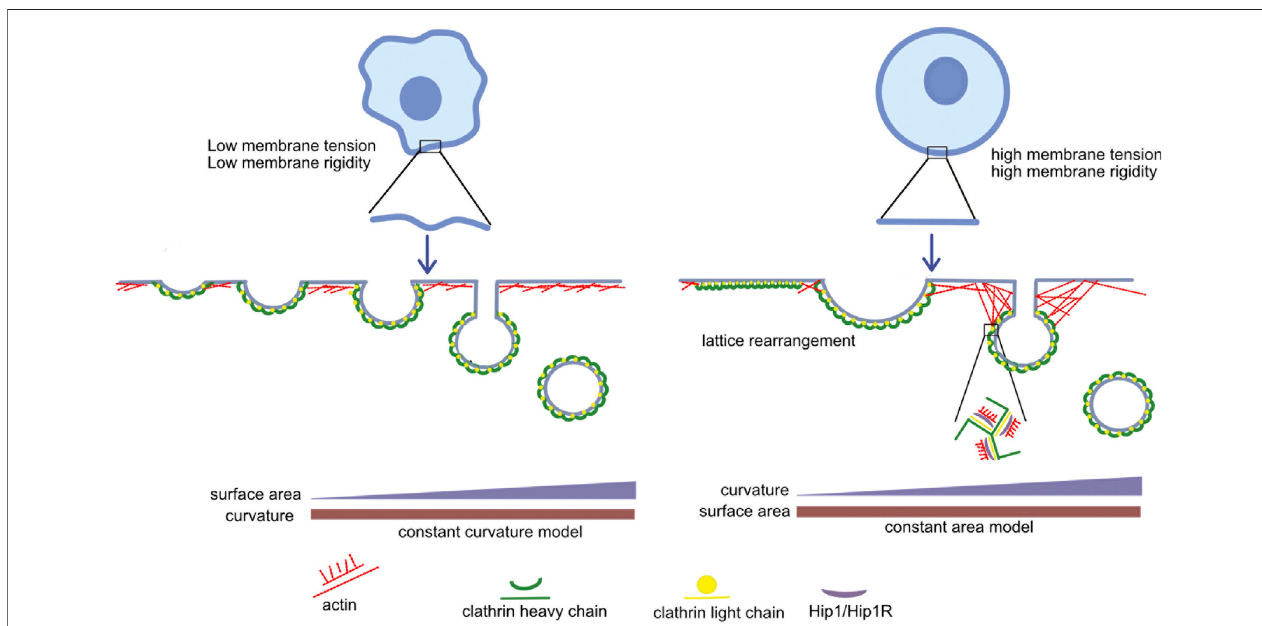
FIGURE 2 | Interaction of clathrin light chains with actin: When forces opposing membrane invagination (such as membrane tension and membrane rigidity) are high,clathrin fi rstassemblesasa fl atlattice,andlightchain-dependentrearrangementtakesplacetointroducecurvature(constantareamodel).Sincethepolymerization energy of clathrin is insuf fi cient to deform the membrane, the actin cytoskeleton is recruited by light chains to further counteract these opposing forces. On the other hand, when forces opposing membrane invagination are low, the polymerization energy of clathrin is suf fi cient to deform the membrane. Clathrin directly polymerizes onto the budding membrane (constant curvature model) and clathrin light chains and the actin cytoskeleton are not required.